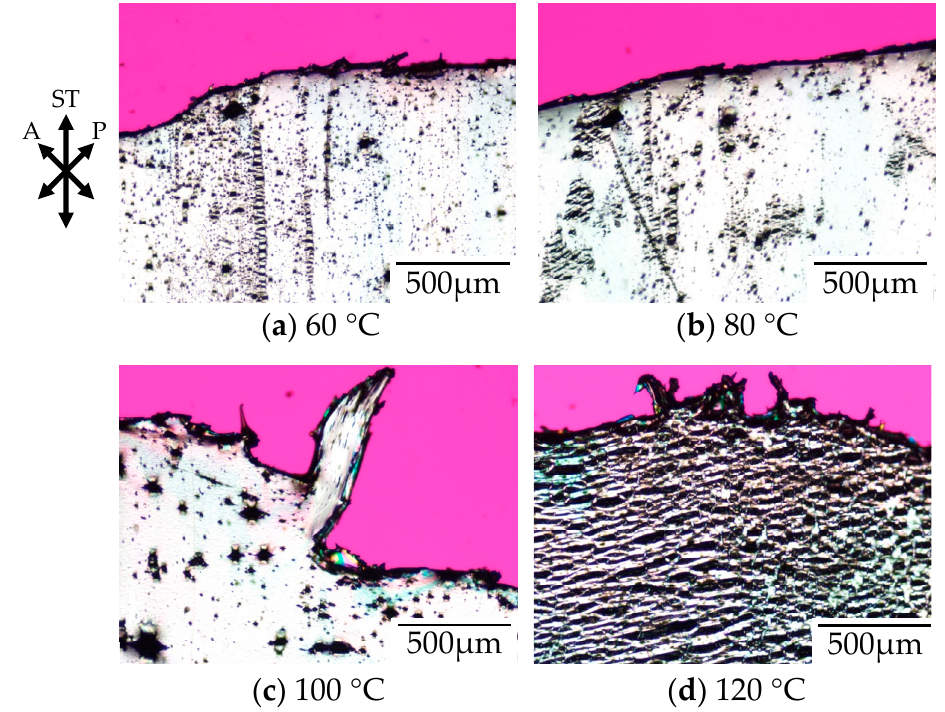
Figure 2. Polarized optical micrographs of stretched-and-fractured low molecular weight polycarbonate for optical disc grade (OD-PC) obtained by stretching under atmospheric pressure at various temperatures.